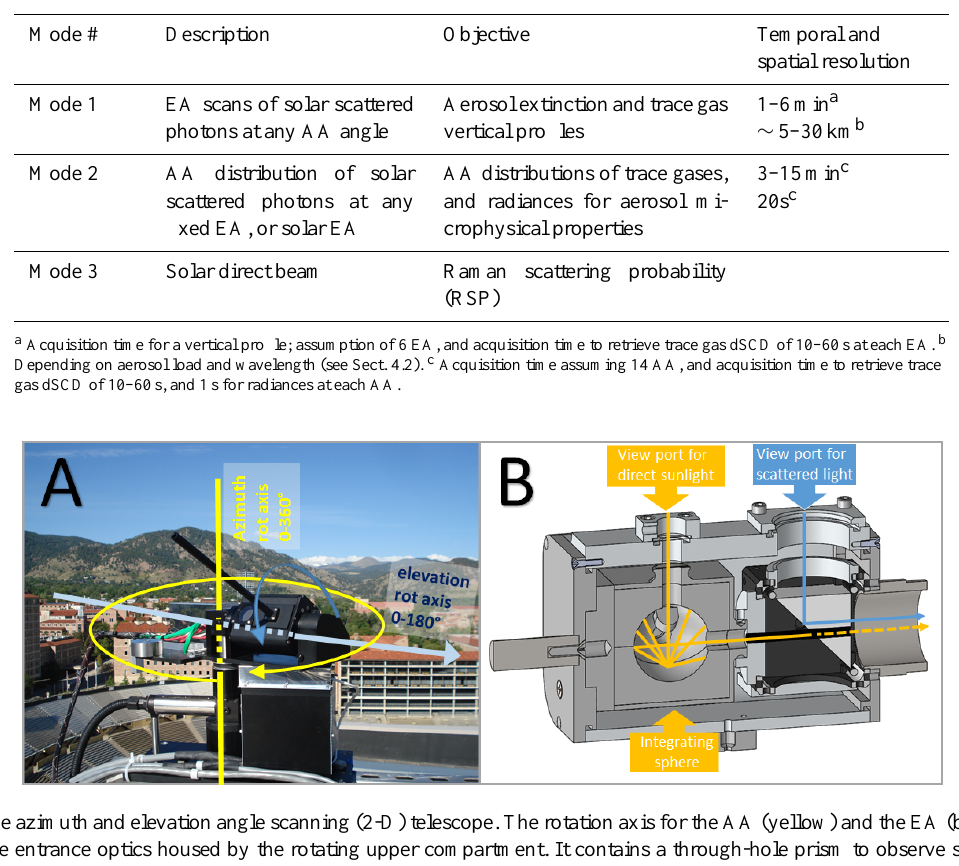
Table 1. The CU 2-D-MAX-DOAS instrument modes of operation.